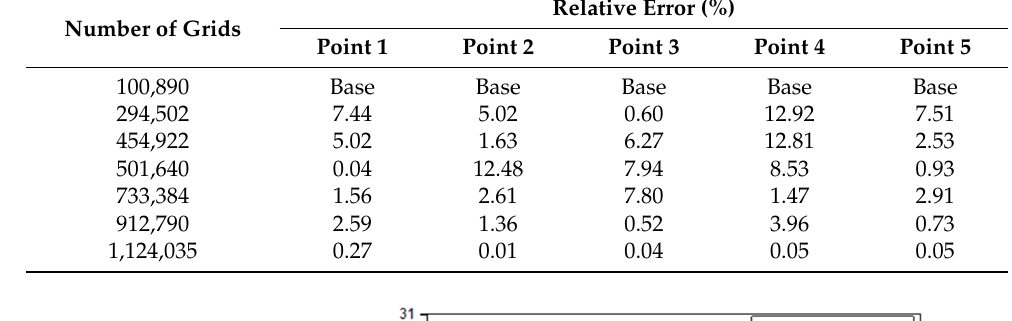
Table 3. The relative error in the number of grids.